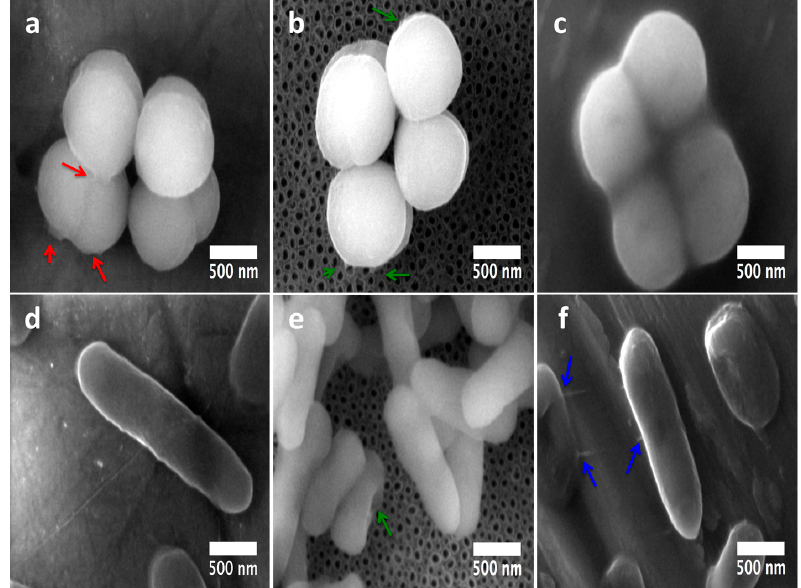
Figure 10. Nano-scale comparative bacteria-surface interactions among Gram-positive and Gram-negative microorganisms over the surfaces at 6 h: ( a ) S. epidermidis on the Flat-Ti6Al4V material (the red arrows highlight the huge contact bonds among the surface and the cell-cell interactions); ( b ) 80 nm NTs illustrating decreased adhesion of S. epidermidis (green arrows points out tiny surface adhesion-bonds); ( c ) S. epidermidis adhesion on the rough material; ( d ) P. aeruginosa largely disseminated on the Flat Ti6Al4V; ( e ) deformed bacilli interaction on NTs (the green arrow represents deformed morphology of direct interacting bacteria to the NTs); ( f ) P. aeruginosa growth on the rough material (the blue arrows show the bacterial interaction bonds above the surface).